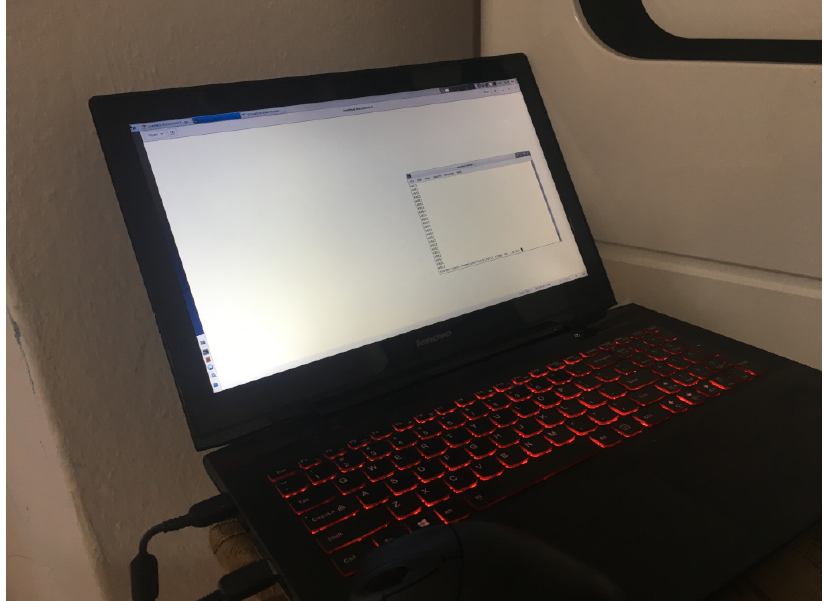
Figure 5. Scene view with the computer screen directly visible to the